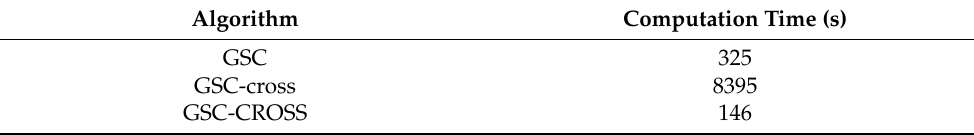
Table 4. Imaging speed with covariance matrix and cross-covariance